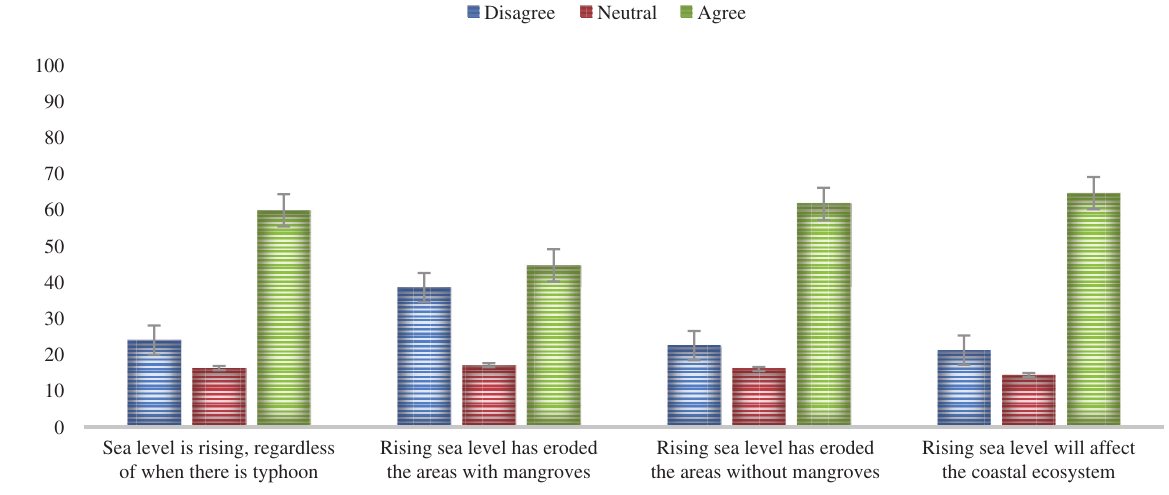
Table 3. Results of linear regression model exploring the association between participants’ socio-demographic characteristics and their awareness; socio-demographic characteristics and risk perceptions of climate change impacts in the coastal marine ecosystem in Palawan, Proportion of participants’ risk Philippines (standard errors in perceptions on the individual variables regarding ‘sea level rise impacts’ (n = 291). (Source: Authors, 2022.)